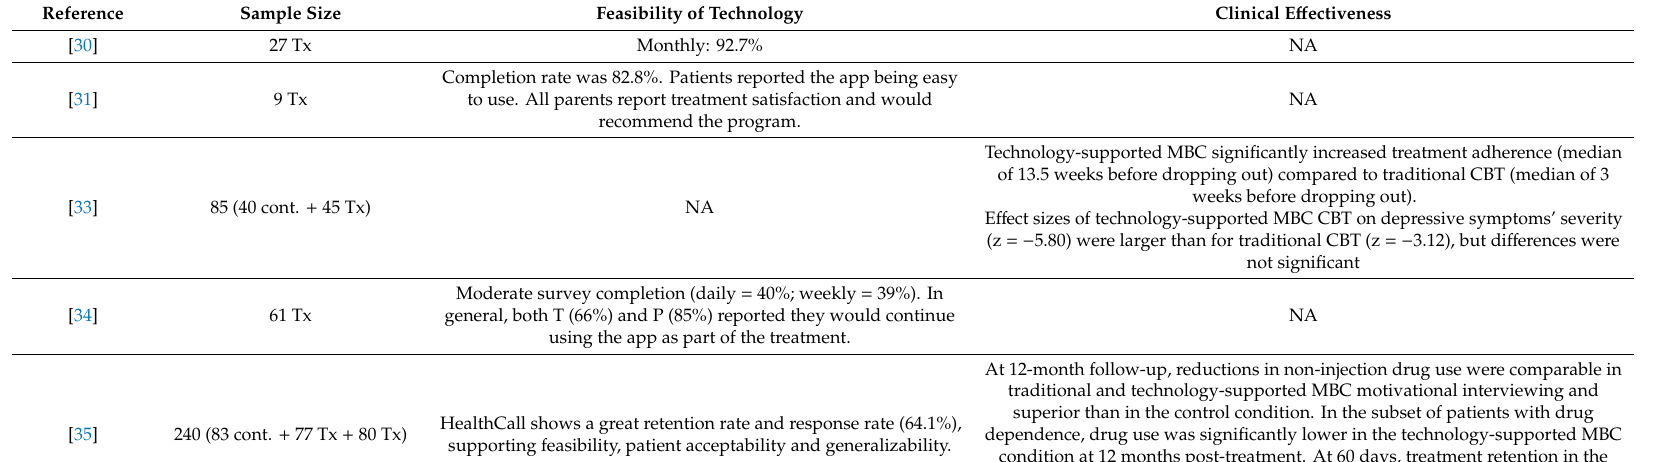
Table 3. Usability, acceptability, and e ff ectiveness of technology-supported measurement-based